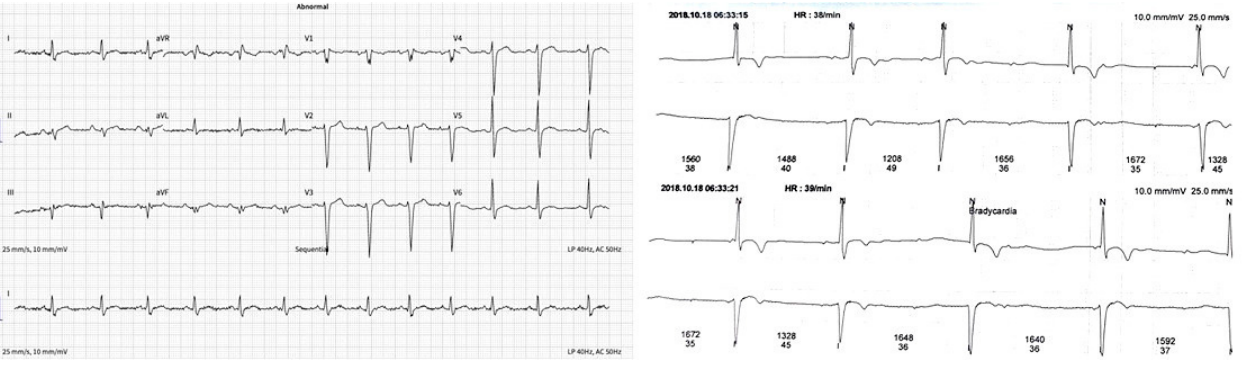
Figure 1. ( a ) ECG–without significant changes; ( b ) ECG–an intermittent second-degree AV block. Table 1. Clinical